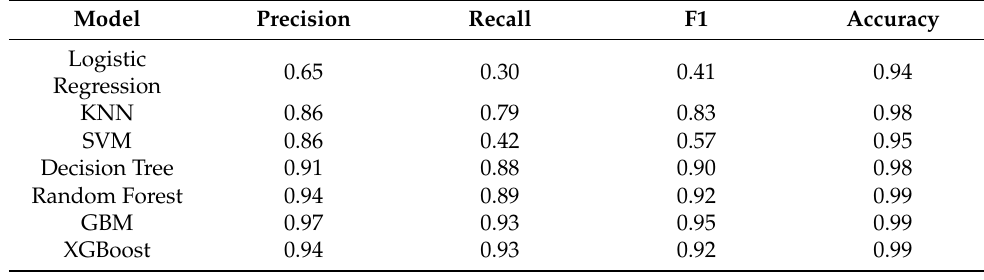
Table 15. Classification precision, recall, and F1 scores of the ML models.